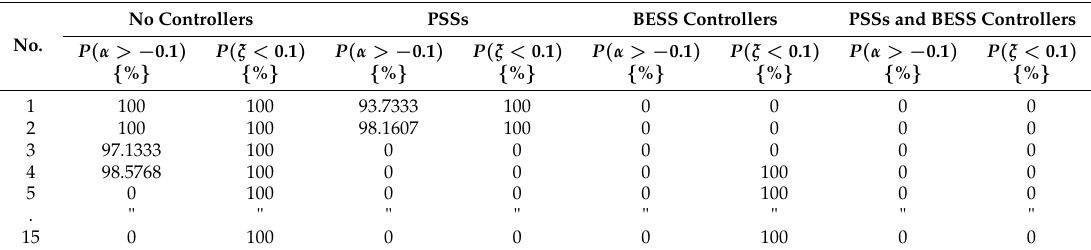
Stability indices under different controller conditions for Scenario 2 using the proposed method.